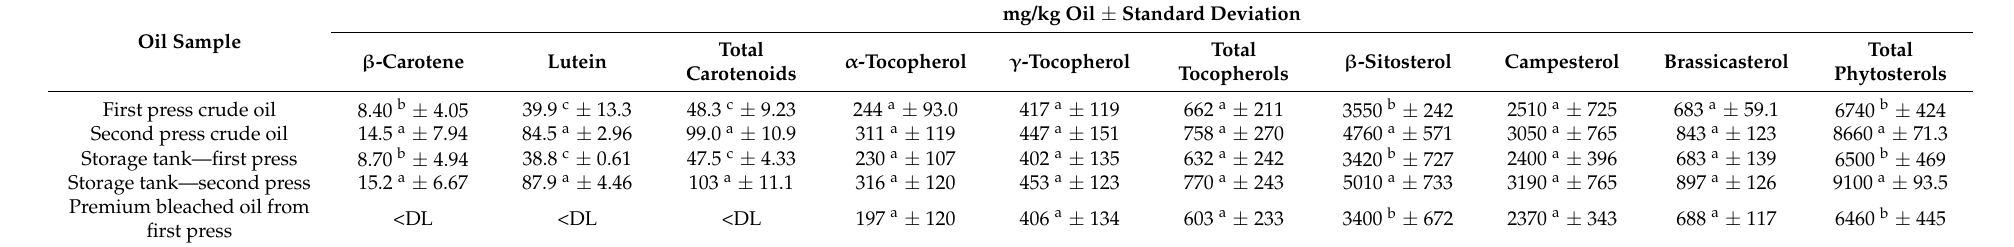
Table 6. Average concentrations of bioactives for crude and bleached oil in process